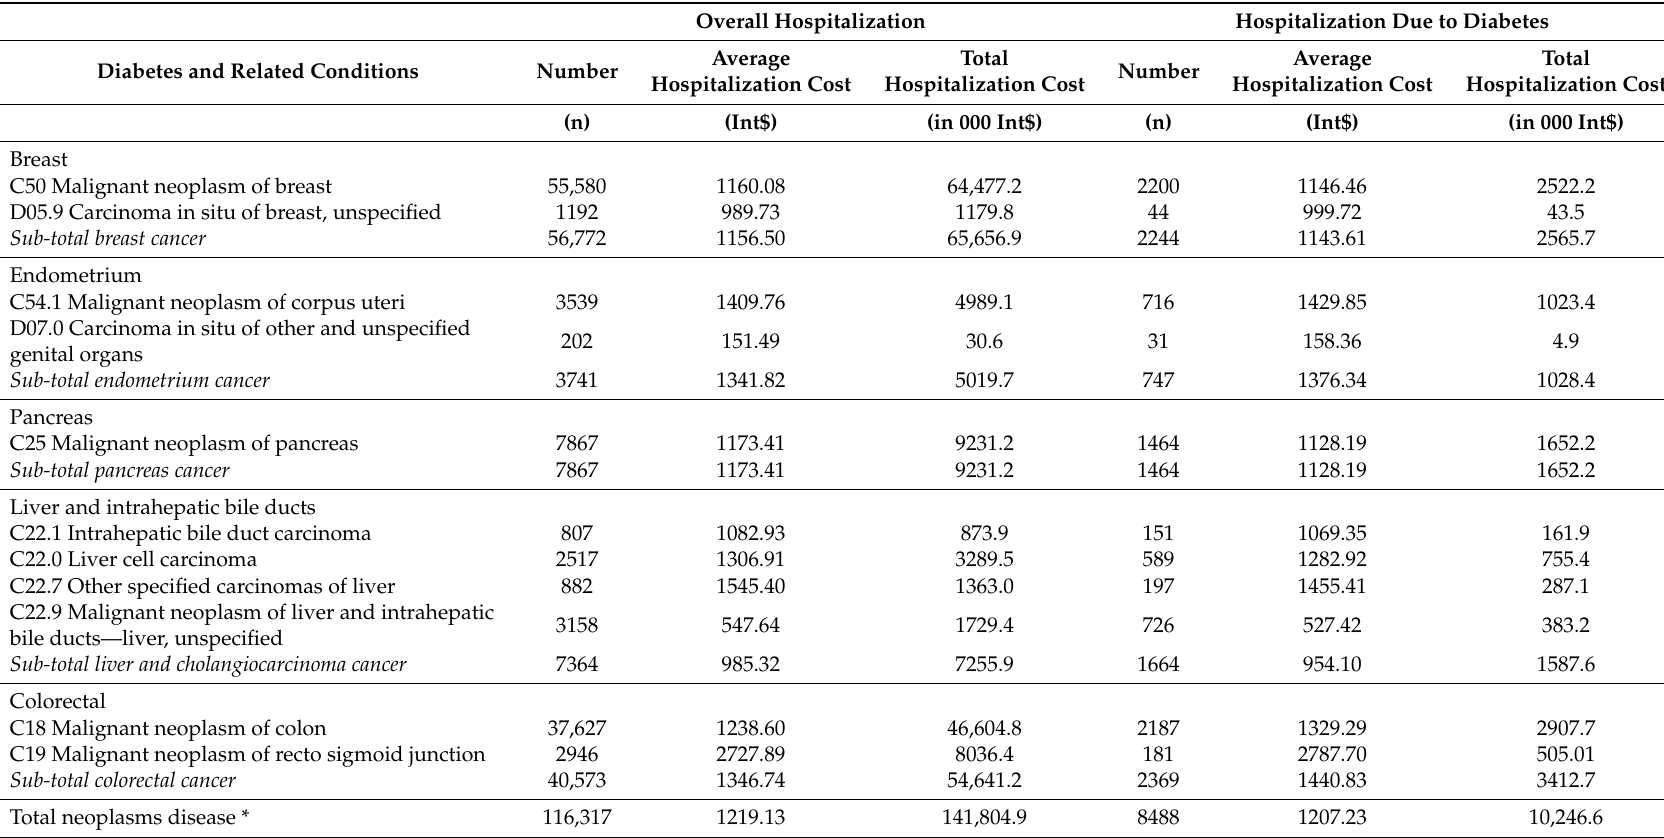
Table 8. Number, average and total hospitalization cost due to neoplasms, overall and related to diabetes, adults (20+ years), SUS, Brazil,